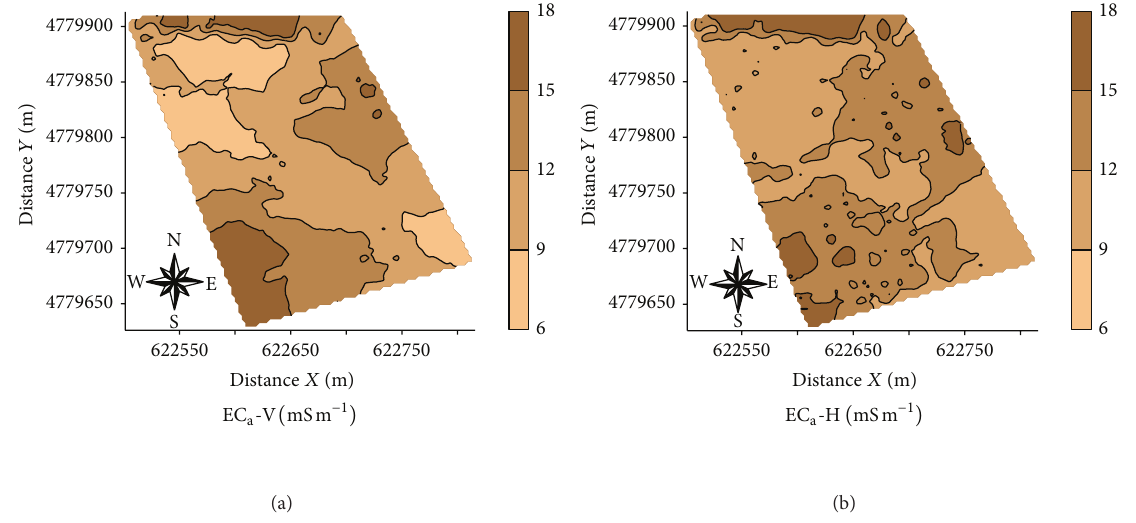
Figure 3: Maps of soil apparent electrical conductivity (EC